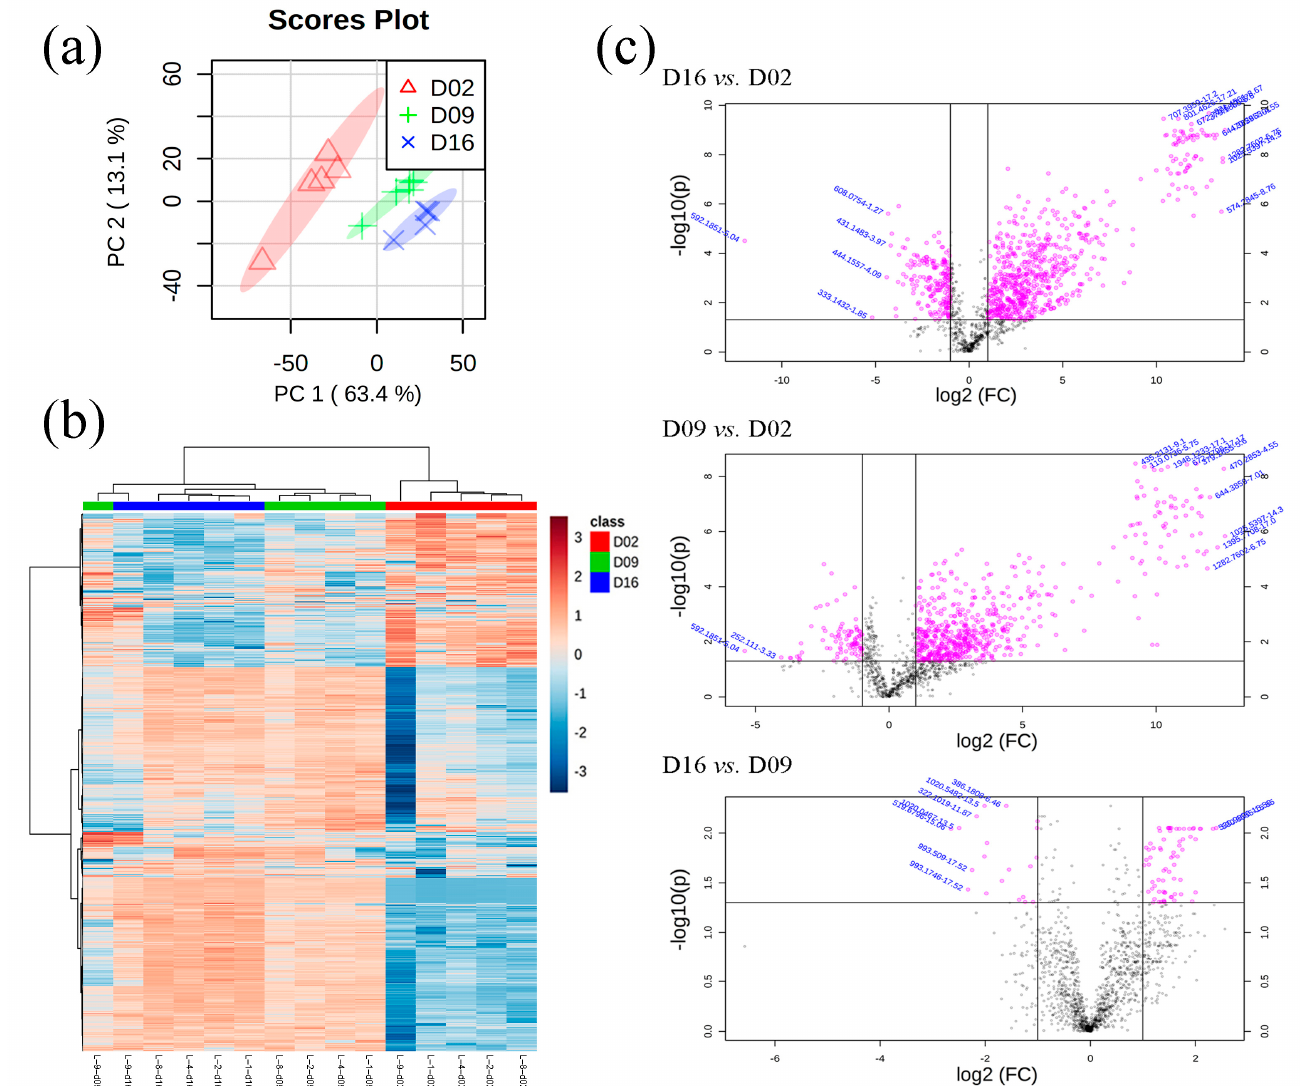
Figure 4. The principal component analysis (PCA) score plots ( a ), hierarchical cluster analysis (HCA) score plots ( b ), and volcano plots ( c ) of metabolome in pork exudate. D02, D09, and D16 refer to pork exudate from 2 d, 9 d, and 16 d postmortem aging treatments, respectively.